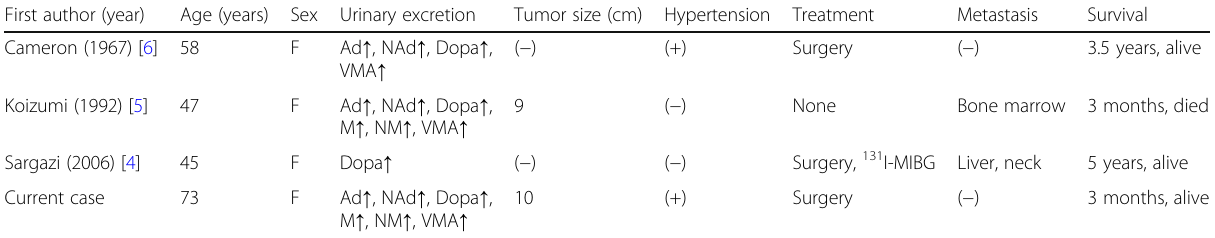
Table 2 Cases of catecholamine-producing ganglioneuroblastomas First author